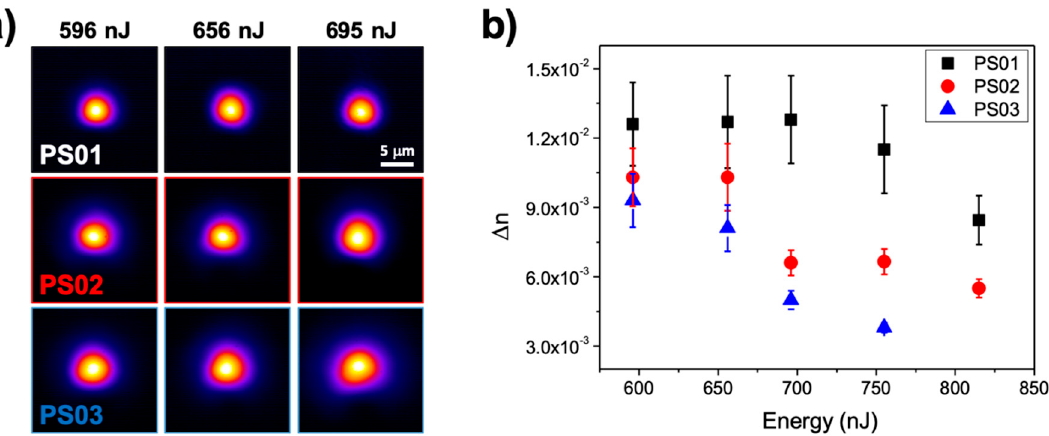
Figure 3. ( a ) Near field images of the guided modes propagated at 1534 nm by the structures shown in Figure 2a. The corresponding compositions and pulse energies are indicated in the ( b ) Refractive index contrast ( ∆ n ) determined from near field measurements (see text) as a function of the writing pulse energy for the three analyzed compositions. The values were estimated using images similar to those in ( a ) at six different wavelengths from 1420 nm to 1640 nm.